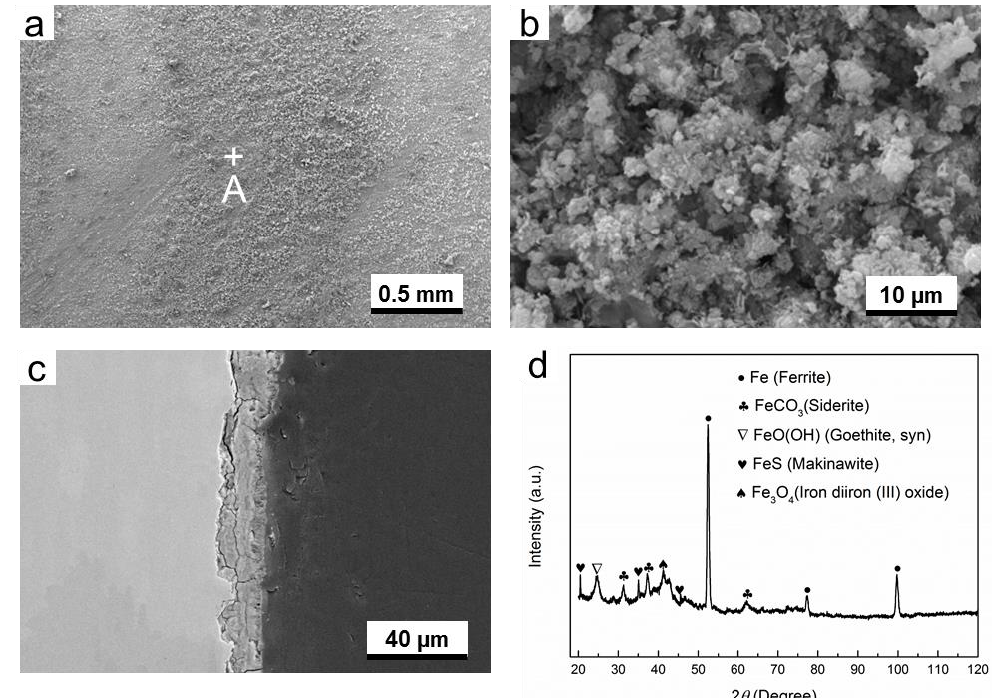
Figure 7. The characterization of corrosion products on G20 steel in liquid phase in H 2 S-containing environment: ( a ) SEM image of the surface of corrosion products, ( b ) the higher magnification of region A marked in ( a ), ( c ) corrosion-sectional image of corrosion product layer, and ( d ) XRD pattern of the corrosion products.